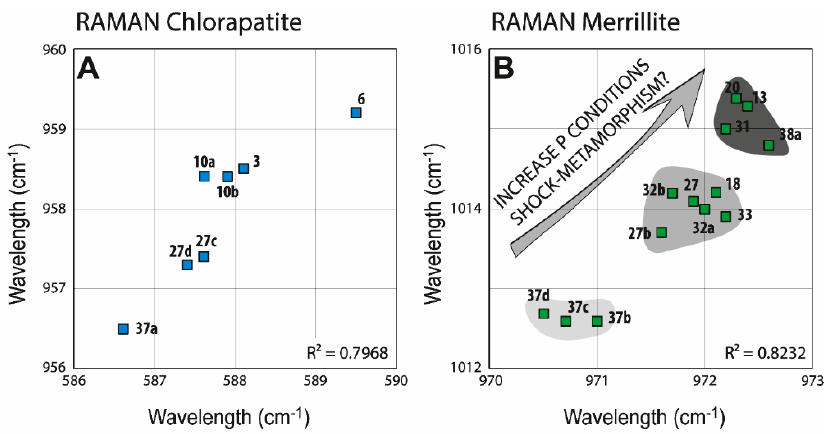
Figure 8. Bivariate diagrams of main peak positions in the Raman spectra, with their correlation coefficients. ( A ) Raman Cl-apatite peaks. ( B ) Raman merrillite peaks.